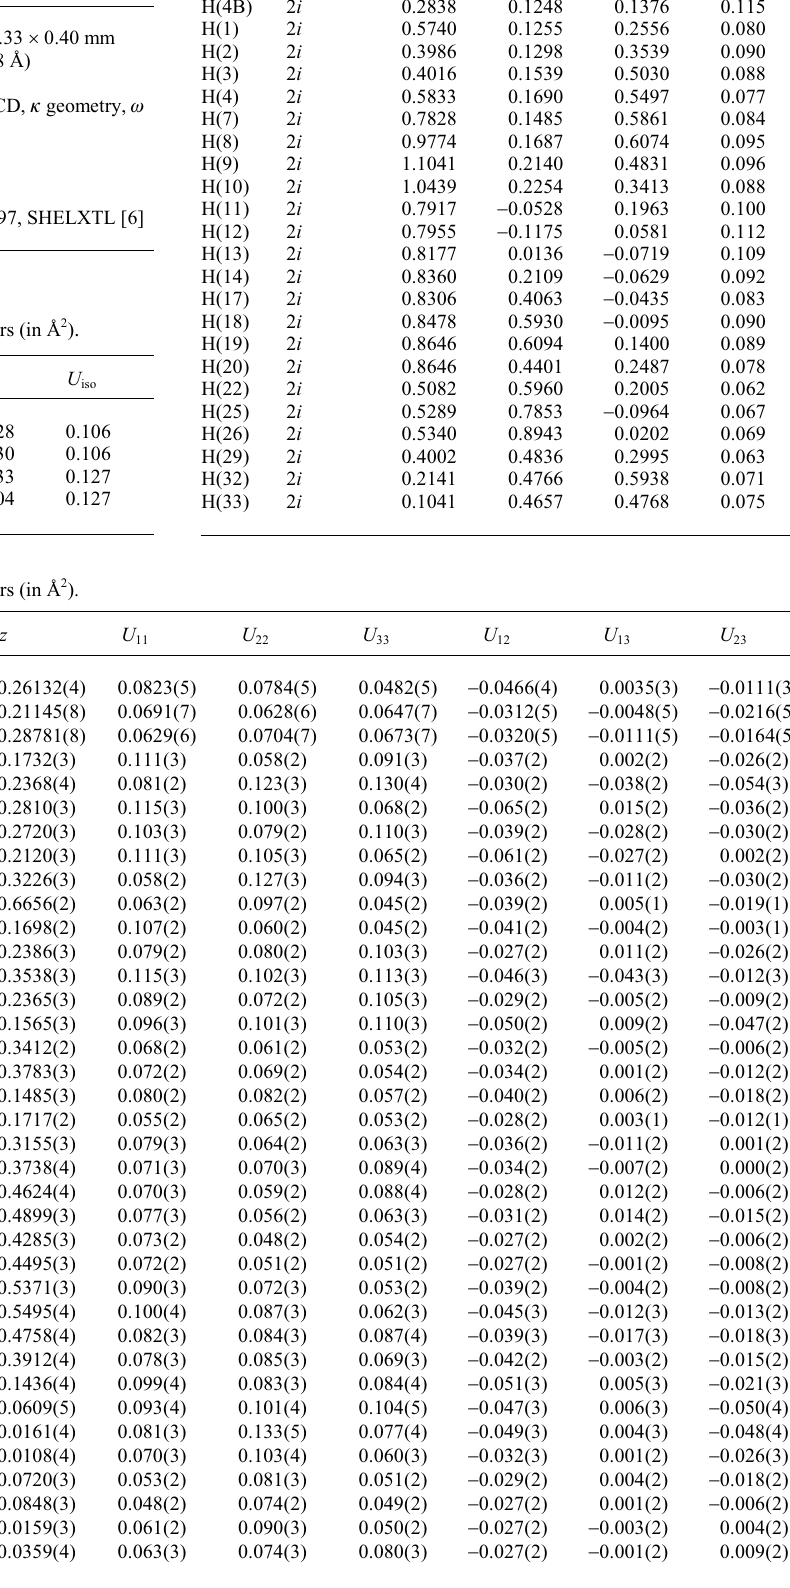
Table 1. Data collection and